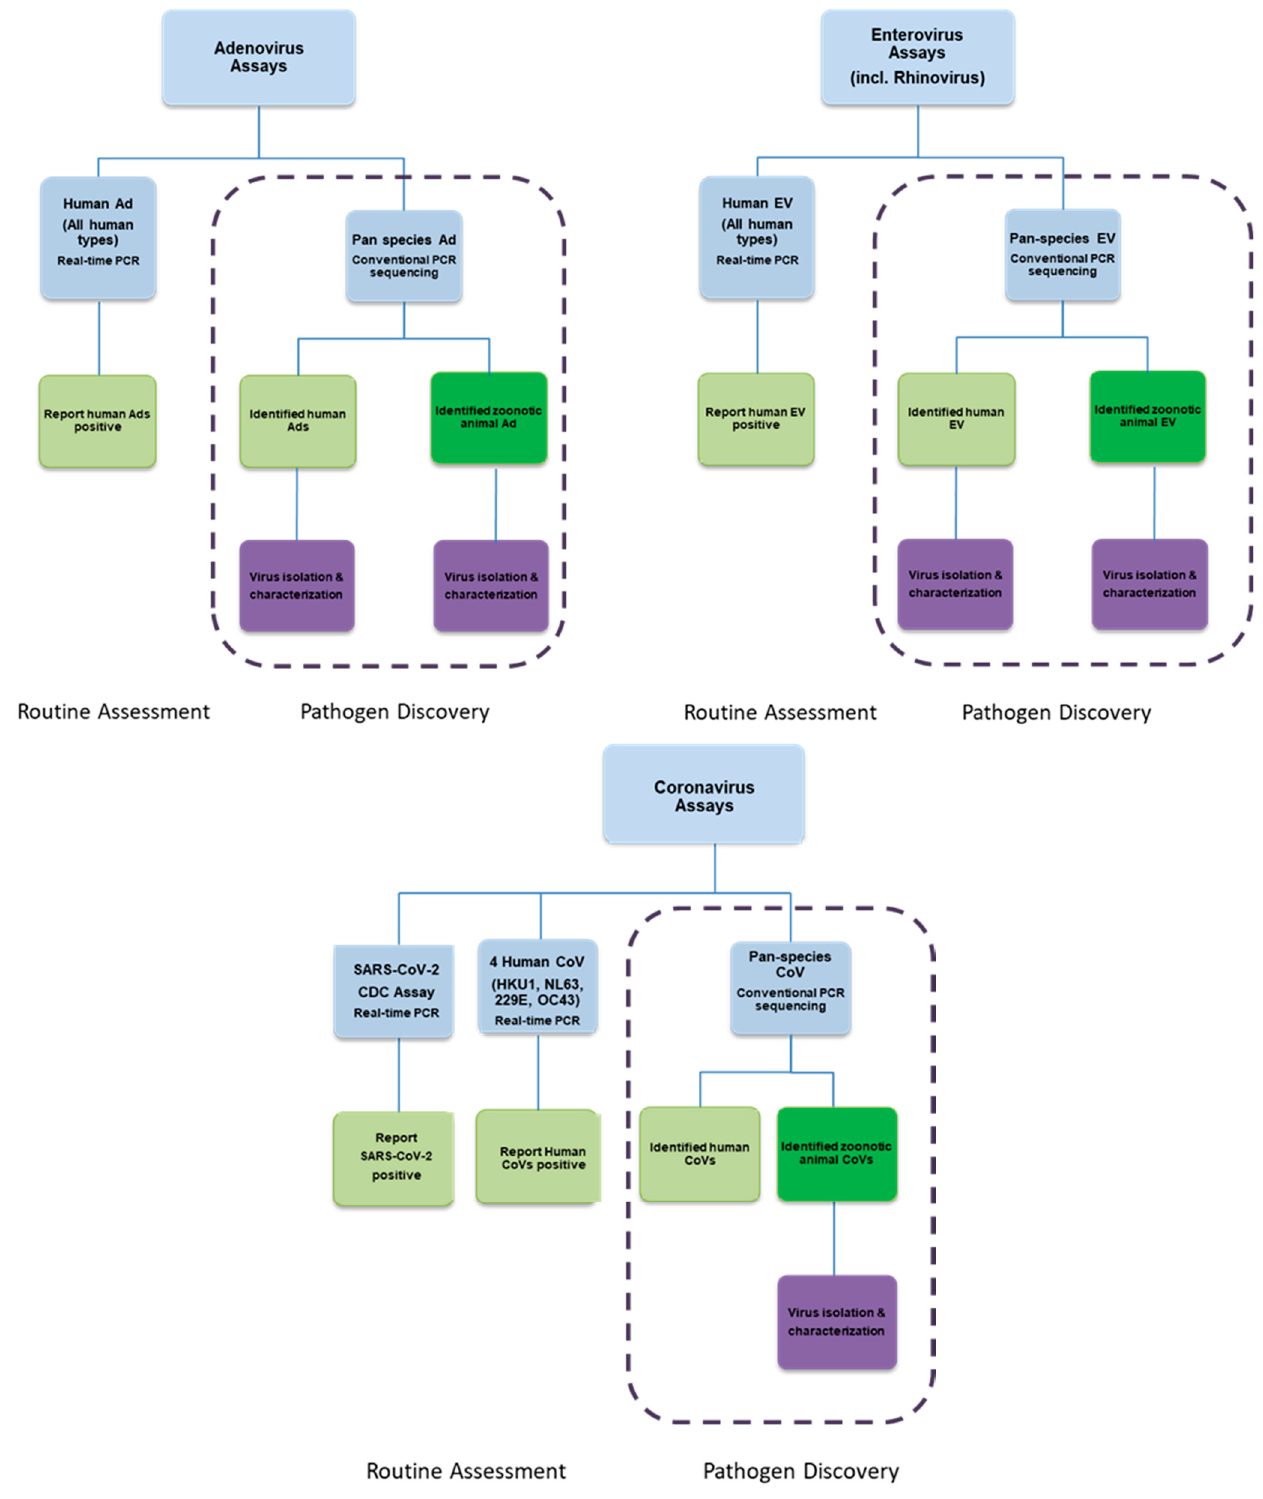
Figure 6. Molecular detection assays for adenovirus (Ad), enterovirus (EV), and coronavirus (CoV). In these algorithms, we combine qPCR/qRT-PCR, and conventional pan-species PCR/qRT-PCR work to detect and characterize both previously recognized and novel human or animal viruses.